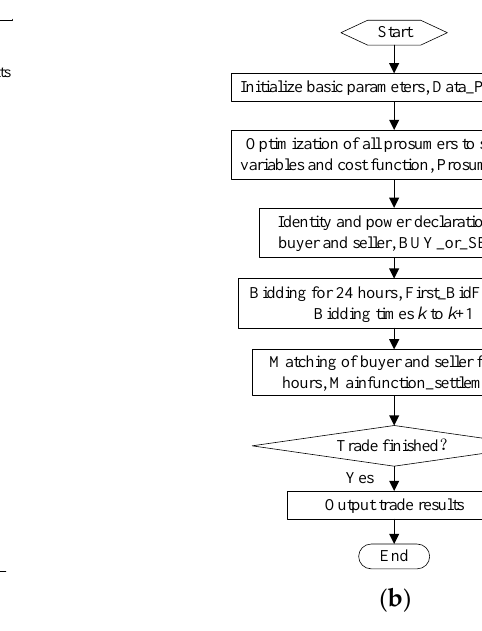
Figure 4. The pseudo-code and the flow chart of simulation process. ( a ) Pseudo-code of the optimi- zation; ( b ) Flow chart of the whole